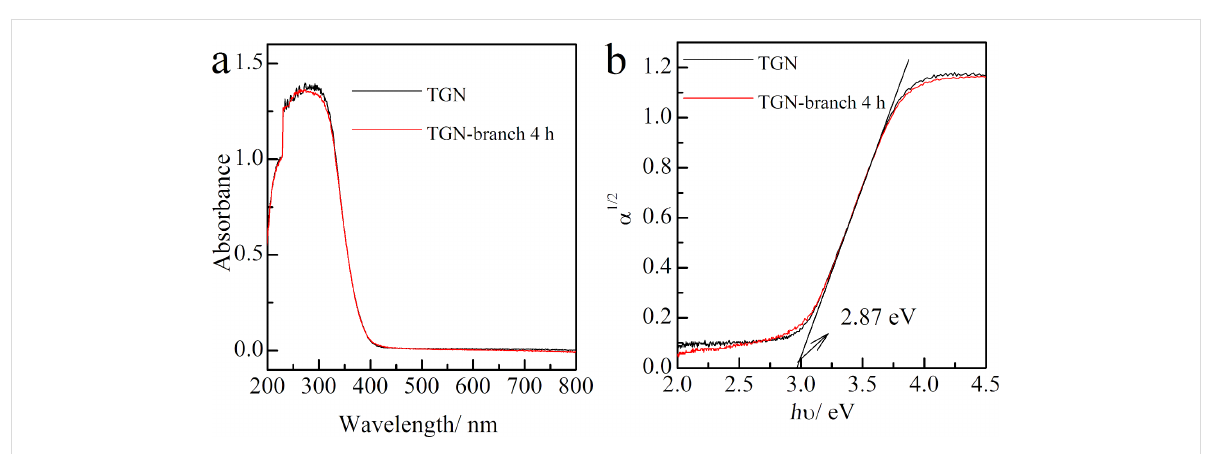
Figure 6: (a) UV–vis diffuse reflectance spectra of TGN and TGN-branch 4 h. (b) Re-plotting of (a) in the α 1/2 ~ h ν coordinate to evaluate the corre- sponding band gap, assuming an indirect transition between bands for TiO 2 .